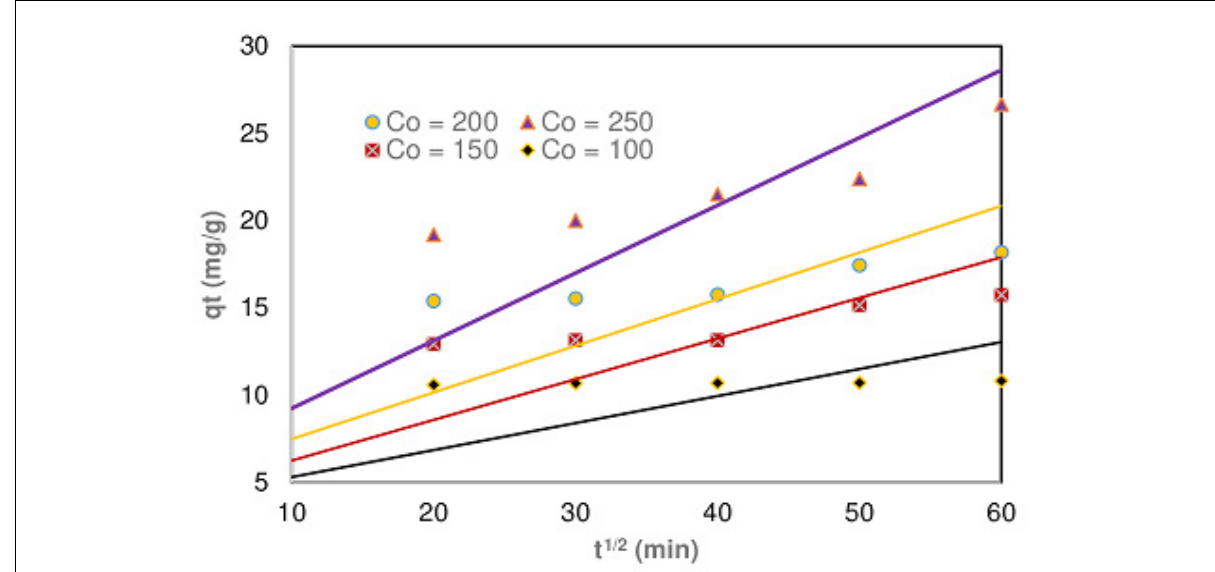
Figure 8: Intra-particle diffusion model fitted to batch equilibrium data for edible oil wastewater photodegradation.